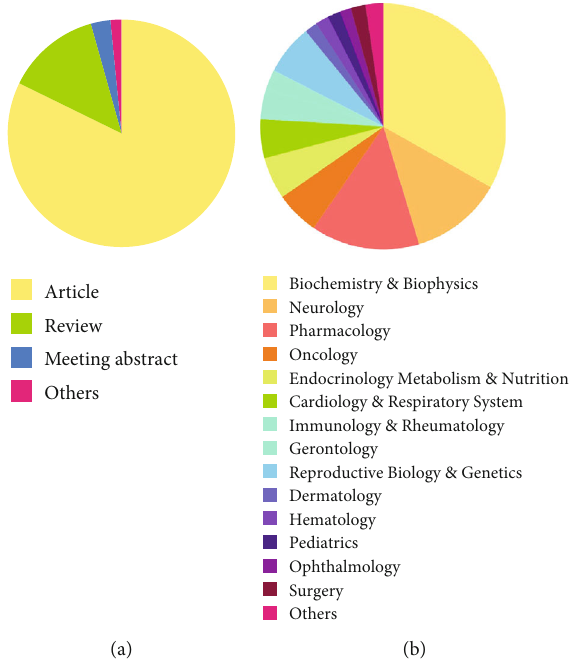
Figure 2: (a) Distribution of article types. (b) Distribution of research areas.